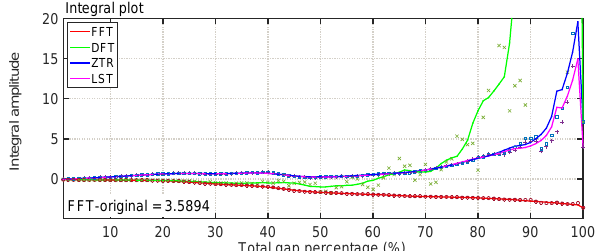
Figure 15. SLG test applied to the VEX data set: integral ampli- tudes as a function of TGP. Shown are the results for: FFT (red), DFT (green), ZTR (blue) and LST